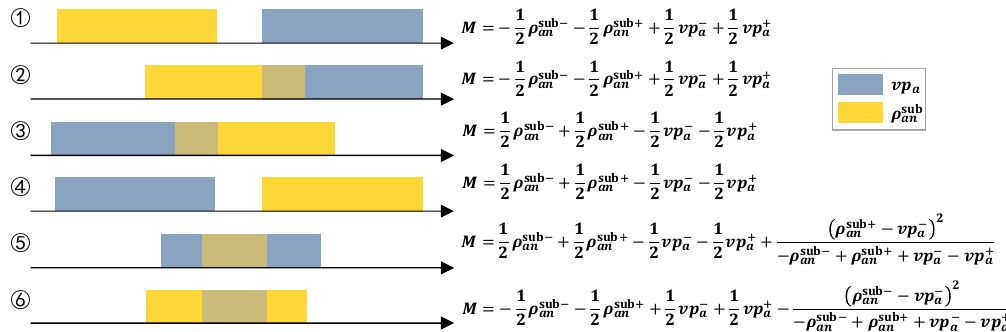
Figure 2. Positional relationships and distance formulas between 𝑣𝑝 (cid:3028) and 𝜌 (cid:3028)(cid:3041)(cid:2929)(cid:2931)(cid:2912) . 5. Calculate the value function through M = m ( vp a , 𝜌 (cid:3028)(cid:3041)(cid:2929)(cid:2931)(cid:2912) ). The value function is the function